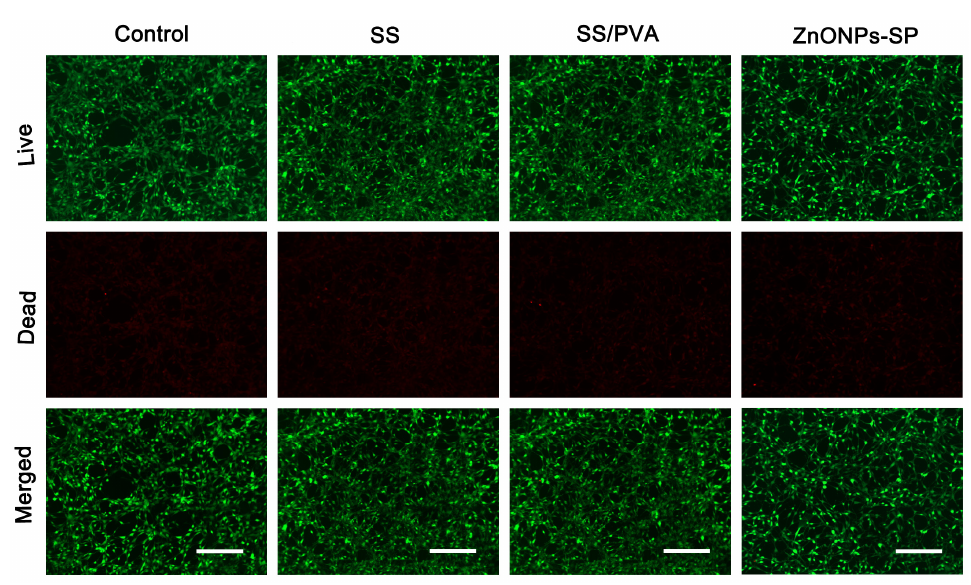
Figure 8. The cytocompatibility of ZnONPs-SP sponge. ( a ) CCK-8 analysis, ( b ) Cells morphology imaged on an optical microscope after 24 h. PBS was used as control. Scale bar, 200 μ m.